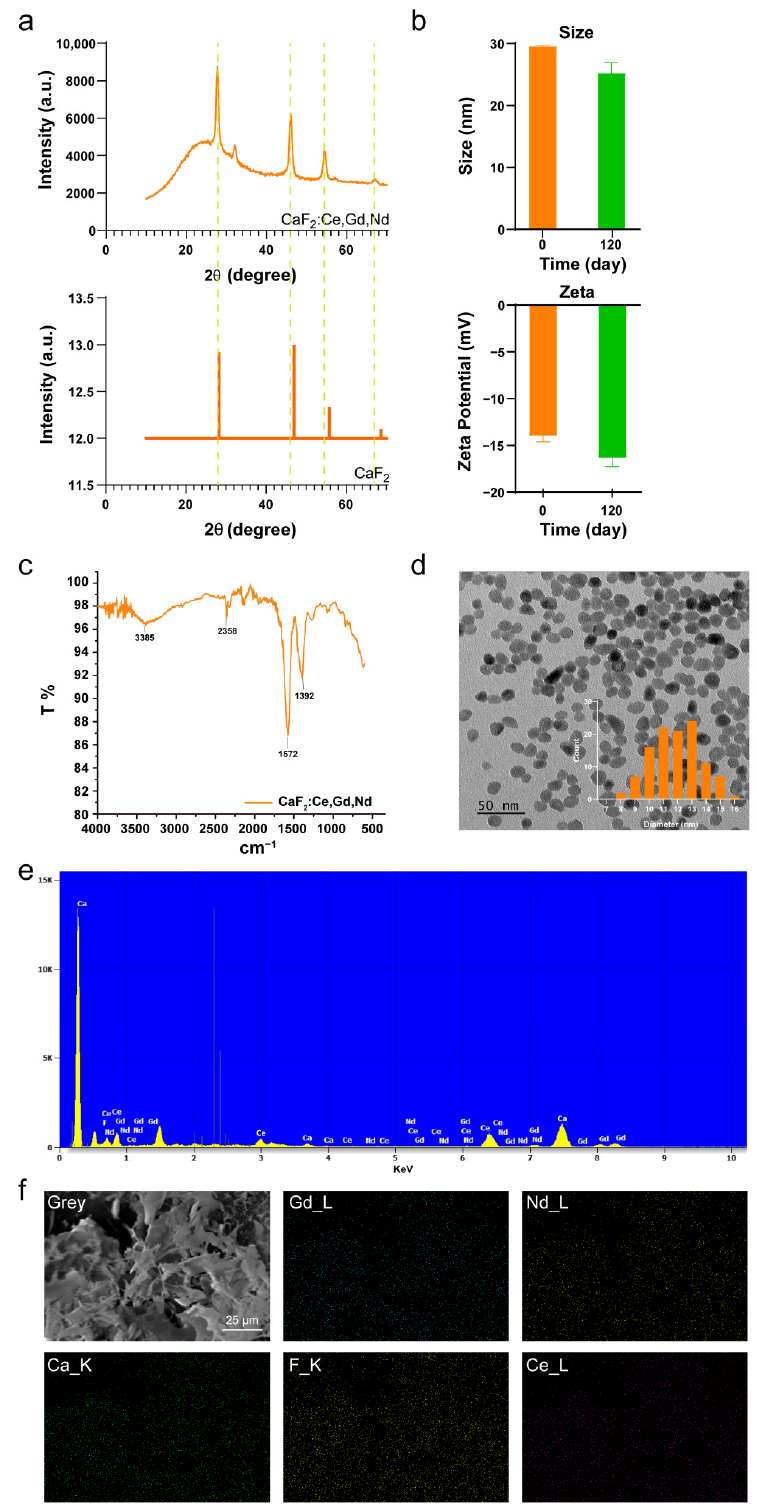
Figure 1. Morphology of CaF 2 : Ce, Gd, Nd NPs. ( a ) XRD images of CaF 2 : Ce, Gd, Nd NPs and CaF 2 ; ( b ) DLS image of CaF 2 : Ce, Gd, Nd NPs at 0 d and 120 d; ( c ) FTIR image of CaF 2 : Ce, Gd, Nd NPs; ( d ) TEM images of CaF 2 : Ce, Gd, Nd NPs, where the inset shows the size distribution of CaF 2 : Ce, Gd, Nd NPs; ( e ) EDS spectrum of CaF 2 : Ce, Gd, Nd NPs; ( f ) mapping images of CaF 2 : Ce, Gd, Nd